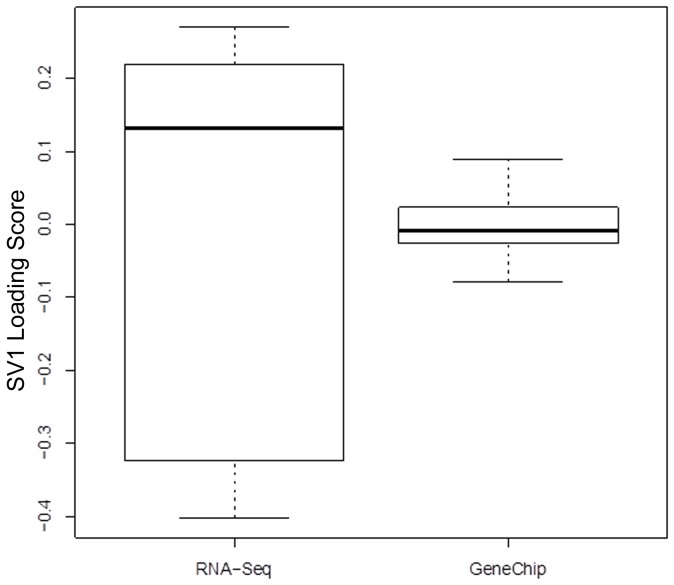
SVA Loadings by Technology.Scores from the first surrogate variable obtained from analysis of the combined RNA-Seq and microarray expression profiles reflect variation among RNA-Seq samples. Unexplained variation in the combined data set was captured using Surrogate Variable Analysis [42], which returns scores and loadings. The distribution of scores from the first surrogate variable is represented in box-and-whisker plots.